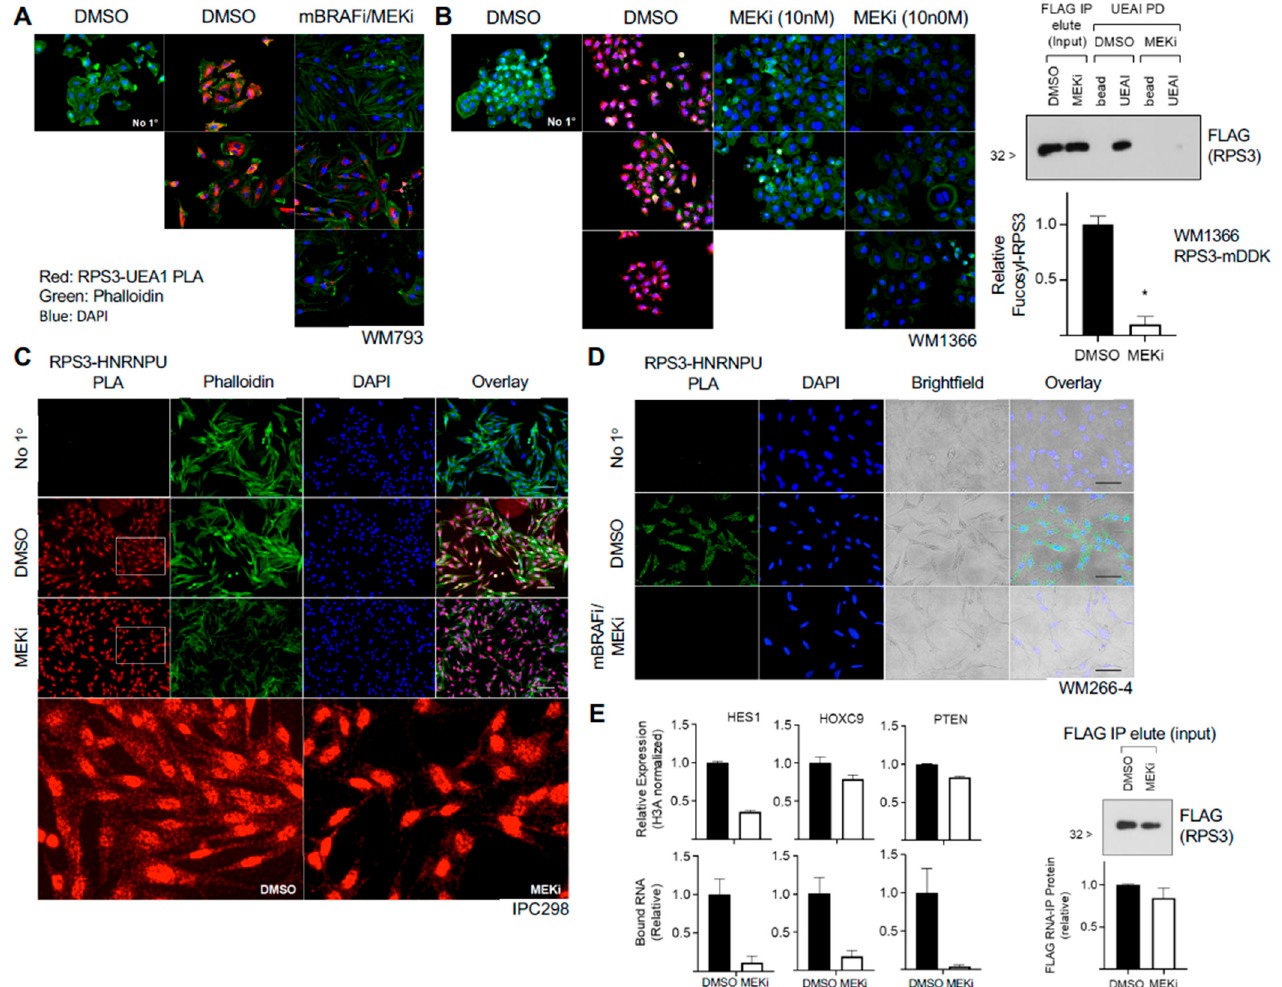
Figure 5. MAP kinase inhibitors decrease RPS3 fucosylation and interaction with RNA. ( A ) Treatment of BRAF-mutant cells with combination mutant-BRAF inhibitor (mBRAFi, PLX4032, 1 µM) and MEK inhibitor (MEKi, trametinib, 10 nM) decreased RPS3 fucosylation as assessed by PLA (red). Cells were grown on glass coverslips and treated for 2 d with inhibitors prior to fixation and analysis. Cells were counterstained with phalloidin (green) and DAPI (blue). No primary (No 1°) was run as a negative control. Several representative fields are shown. ( B ) NRAS-mutant cells were grown on glass coverslips and treated with MEKi (10 nM, 100 nM) for 2 d prior to fixation and analysis for fucosylated RPS3 (red). Cells were counterstained with phalloidin (green) and DAPI (blue). No primary (No 1°) was run as a negative control. Several representative fields are shown. RPS3 IP, elution, and subsequent UEAI-PD on MEKi-treated lysates was conducted to confirm a decrease in RPS3 fucosylation by Western blot. Cells were treated with 10 nM MEKi for 2 d prior to lysis for downstream analysis. Results were analyzed by t -test ( n = 2). ( C ) NRAS-mutant cells were grown on glass coverslips and treated with MEKi (10 nM) or control for 2 d prior to analysis for interaction between RPS3 and HNRNPU by PLA (red). Cells were counterstained with phalloidin (green) and DAPI (blue). No primary (No 1°) was run as a negative control. ( D ) BRAF-mutant cells were grown on glass coverslips and treated with combination mBRAFi (1 µM) and MEKi (10 nM) for 2 d prior to analysis for interaction between RPS3 and HNRNPU as assessed by PLA (green). Cells were counterstained with DAPI (blue) and also visualized by brightfield to observe cell morphology. No primary (No 1°) was run as a negative control. ( E ) NRAS-mutant cells were treated with MEKi (10 nM) or control for 2 d prior to analysis for relative mRNA level and relative binding to fucosylated RPS3. HES1 , HOXC9 , and PTEN were analyzed. Relative expression was normalized to H3A. A fraction of the UEAI-PD input (following RPS3 IP and elution) was taken and analyzed by Western blot as a control for IP efficiency between control and MEKi-treated groups (lower panel). * p < 0.05